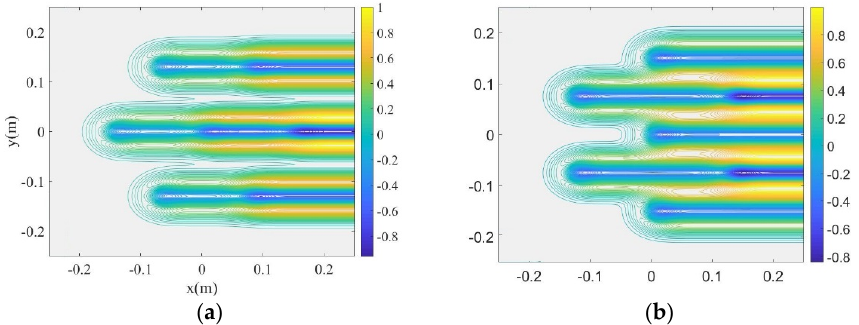
Figure 7. Distribution of temperature difference for 7 incoherent beams, where ( a ) for the arrange ‐ ment in Figure 3a; ( b ) for the arrangement in Figure 6a.